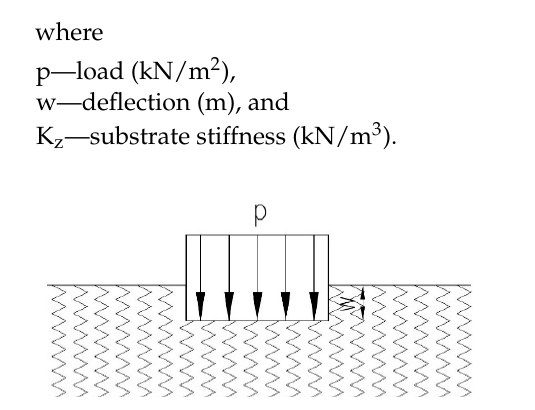
Figure 1. Winkler substrate model (drawn by the author).